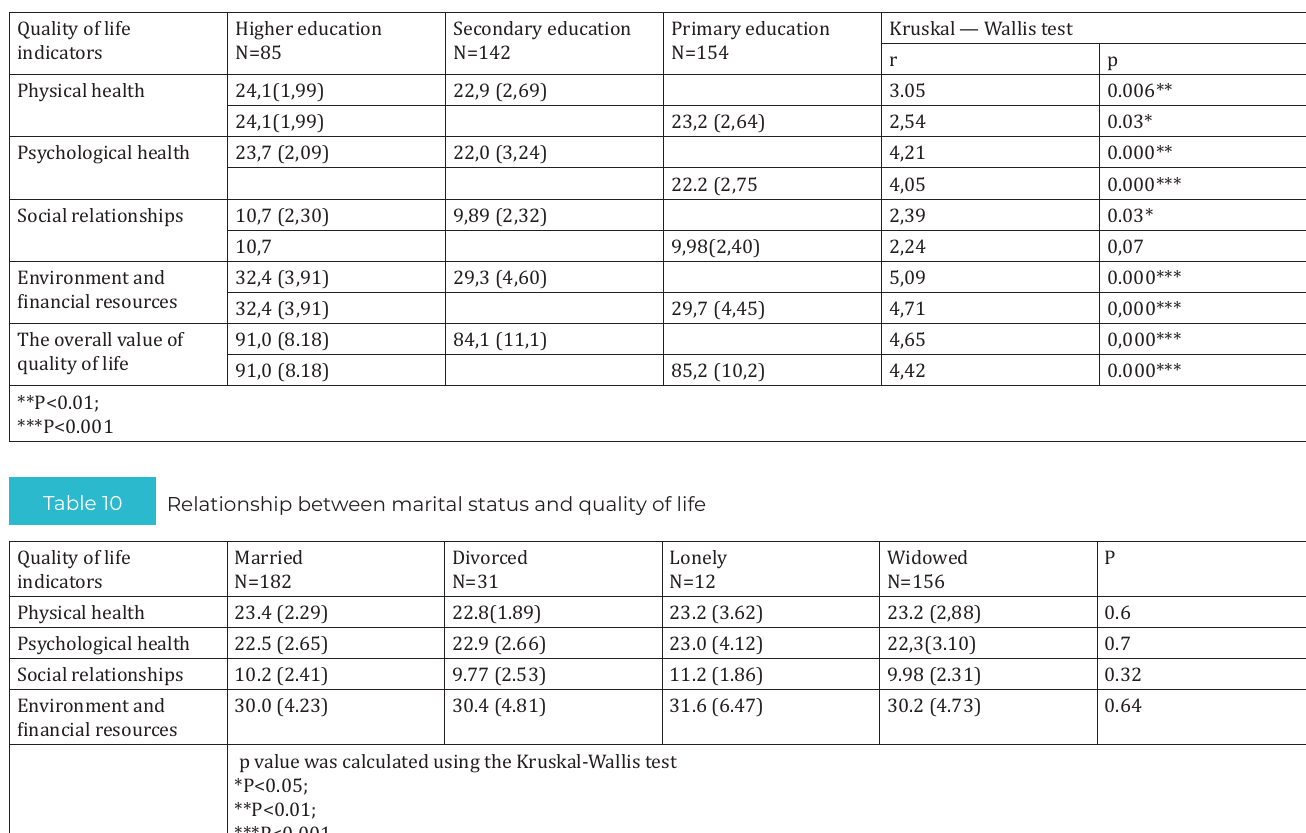
The relationship between educational attainment and quality of life